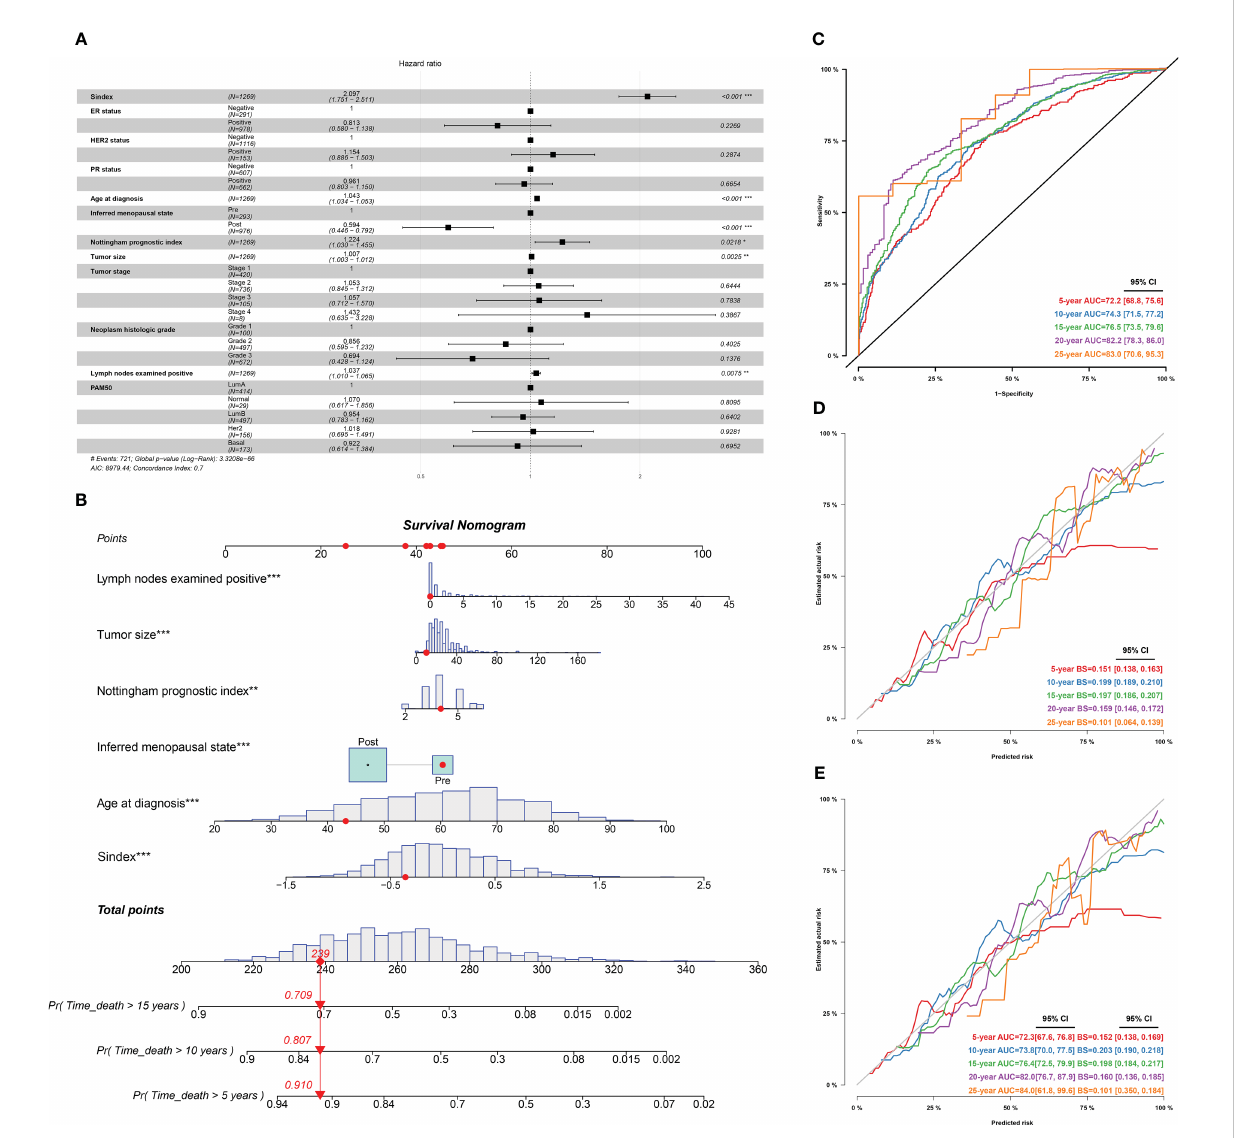
FIGURE 7 Identi fi cation of independent prognostic predictors and validation of the nomogram in predicting overall survival of breast cancer. (A) Forest plots show HR and p-values for Sindex and clinicopathological parameters based on multivariate COX regression. (B) A prognostic nomogram incorporating Sindex and clinical parameters predicting 5-, 10 - and 15-year overall survival of PDAC. (C) Time-dependent ROC for 5-, 10 -,15-,20- and 25-year predictions of overall survival for the nomogram in the METABRIC dataset. (D) . Calibration curves of the nomogram for predicting the probability of OS at 5-, 10 -,15-,20- and 25-year. (E) Internal validation of the nomogram using bootstrapping method *p < 0.05, **p < 0.01, ***p <